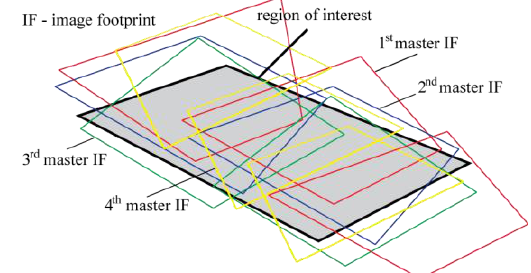
Figure 1. Four sets of master images (each set marked with a distinct color) selected for the dense matching of a ROI.